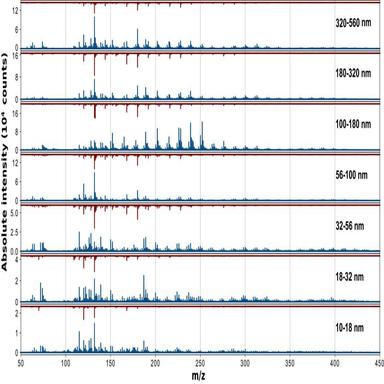
Mass spectra of size-selected particles produced in the HS engine regime and sampled with (red line – HS_CS, top spectra) and without (blue line – HS, bottom spectra) the catalytic stripper. The labels indicate the corresponding NanoMOUDI size-bin.